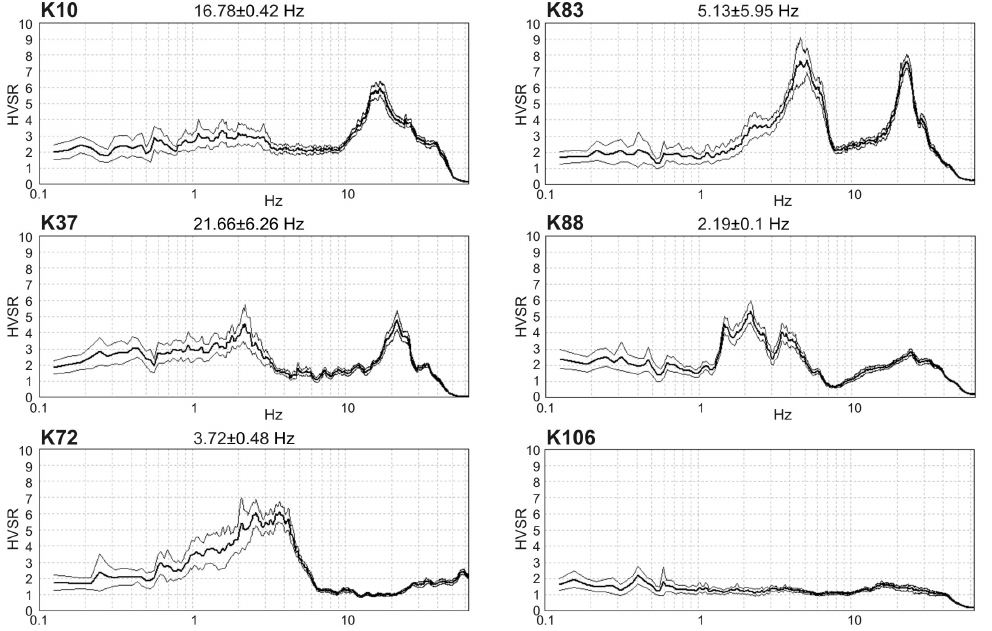
Fig. 4. Some examples of microtremor measurements (HVSR analyses) with more complex shape or flat spectral ratio. Locations of measurements are shown in Fig. 2. Thin lines represent the 95% confidence interval.